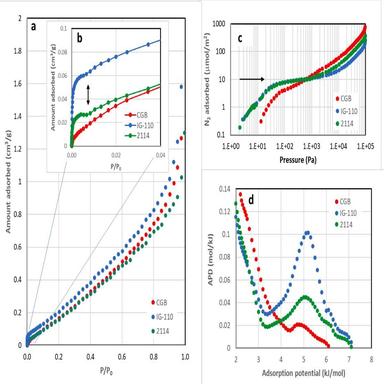
Comparison of internal pore surface properties in CGB vs. IG-110 and 2114 superfine nuclear graphites. Data are derived from N2 adsorption measurements: (a) full-scale adsorption isotherms, (b) sub-monolayer adsorption isotherms, (c) logarithmic plots of surface-normalized excess adsorption data, and (d) adsorption potential distribution.